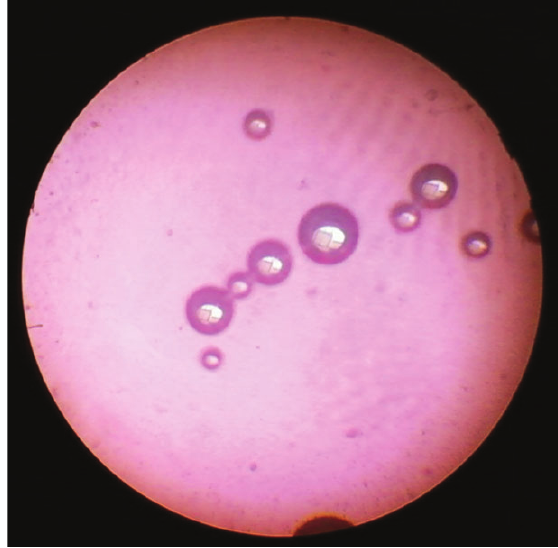
Figure 1 A photograph showing the presence of xanthan-gum- facilitated w/o/w emulsion structure; continuous aqueous phase (red); dispersed organic phase